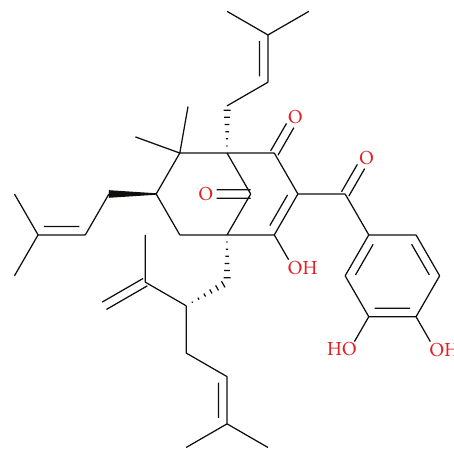
Figure 10: Structure of Garcinol.